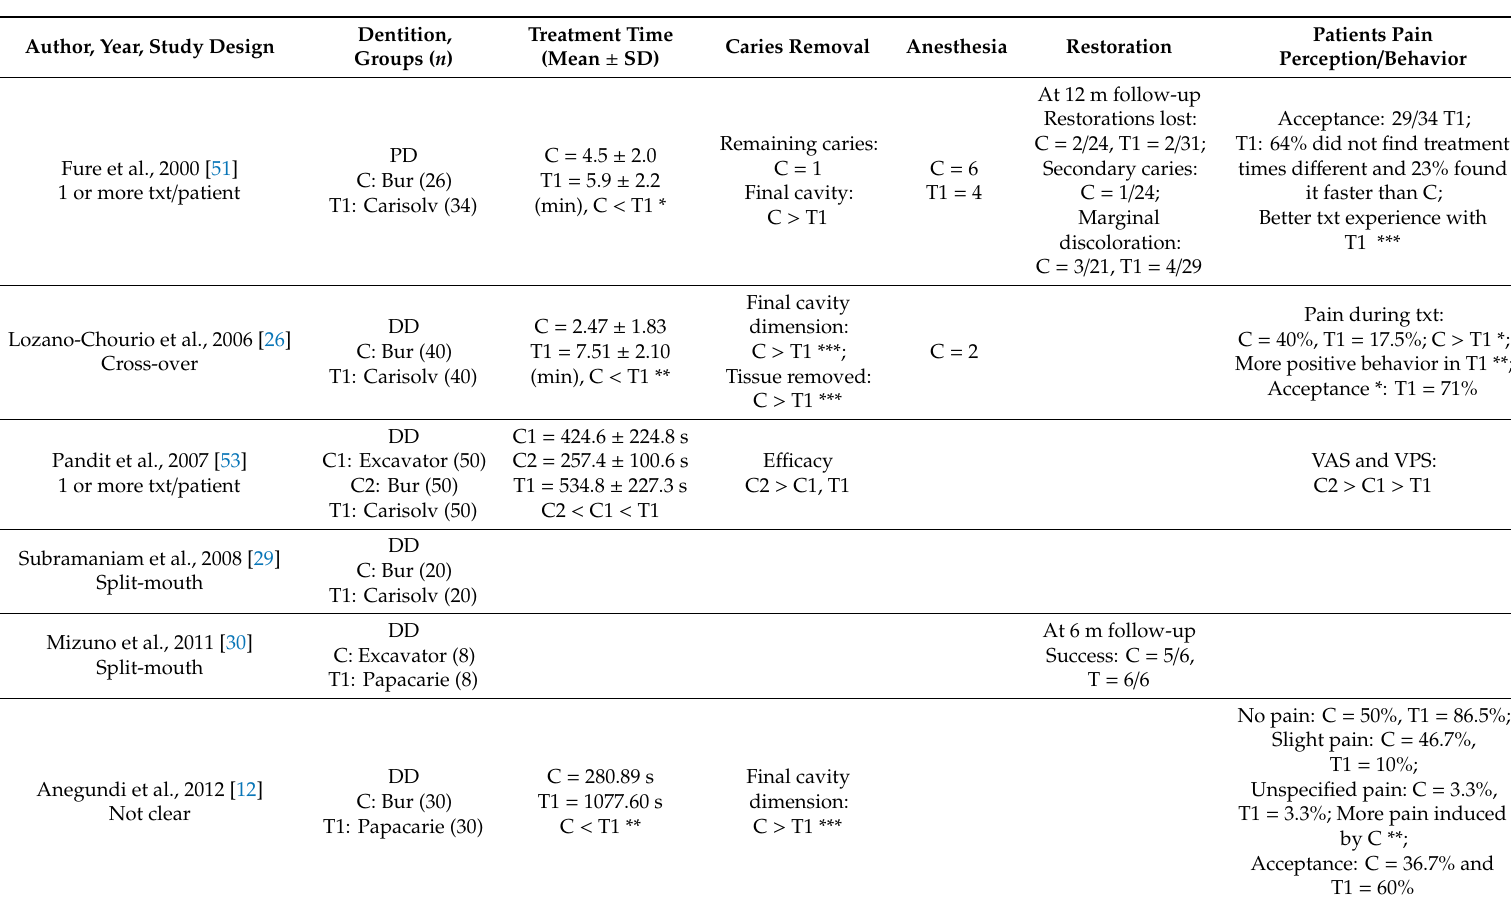
Table 4. Chemomechanical caries removal systems versus